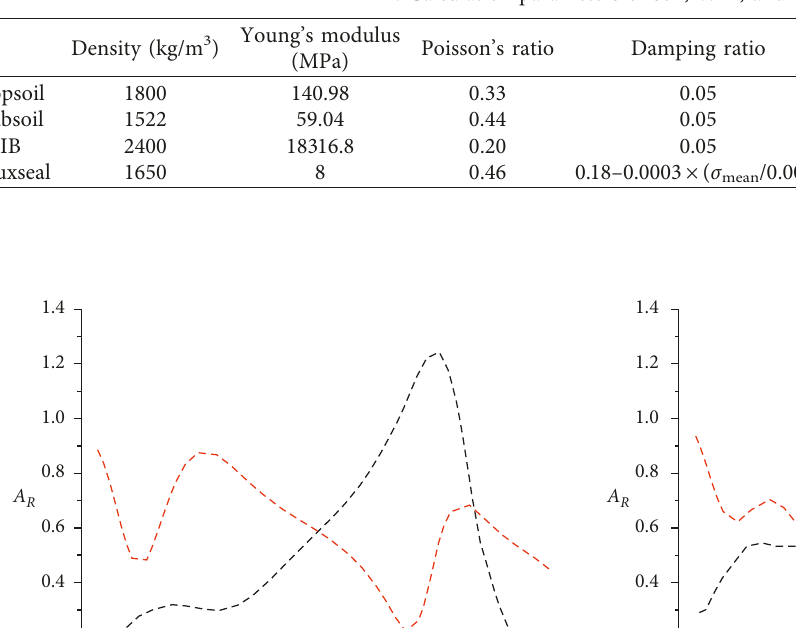
Figure 10: Variation curve of A R of ground displacement with distance for various Duxseal embedded depths: (a) radial displacement and (b) vertical displacement. Table 2: Calculation parameters of soil, WIB, and Duxseal.